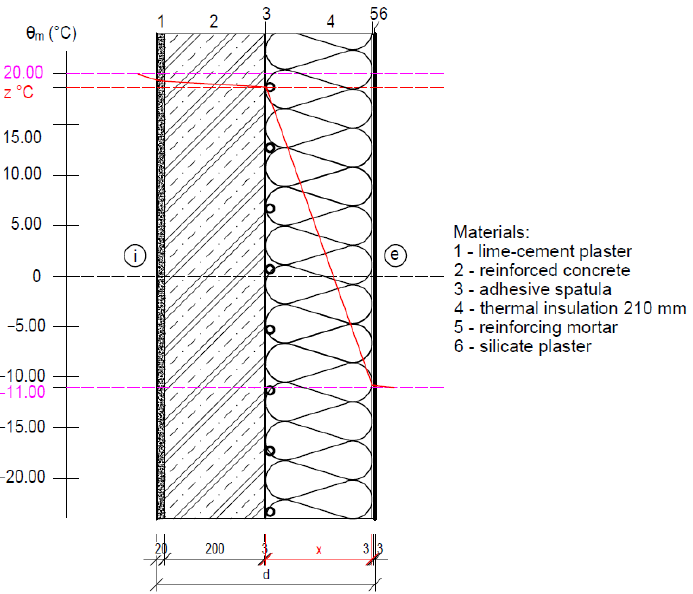
Figure 16. Reinforced concrete wall 200 mm thick with thermal insulation 210 mm thick on the outside. θ m —the temperature in construction ( ◦ C), d—construction thickness (mm), x—thickness of thermal insulation, z—the temperature between the load-bearing and thermal insulation layer of the structure ( ◦ C), e—exterior, and i—interior.